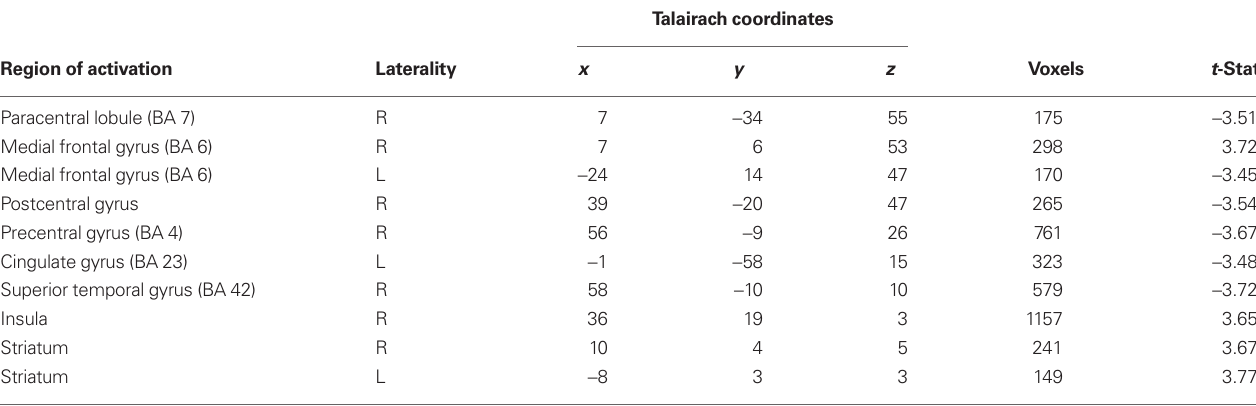
Table 1 | Conjunction analysis investigating voxels commonly recruited during aversive conditioning with primary and secondary reinforcers ( p <